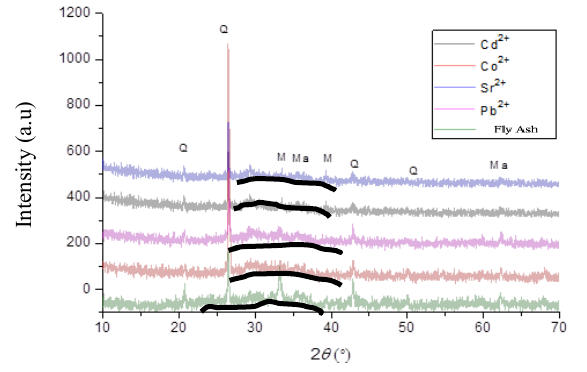
Fig. 5. XRD Patterns of fly ash and Heavy Metal-Geopolymer The changes in the diffraction pattern from fly ash to geopolymer with the formation of a new amorphous phase, such as aluminosilicate, were indicated by a hump shift at an angle of 2θ between 20° and 37° to 22° and 41°. The presence of a small peak at 2θ around 22° indicate d the presence of traces of quartz. After reacting with the activating solution,